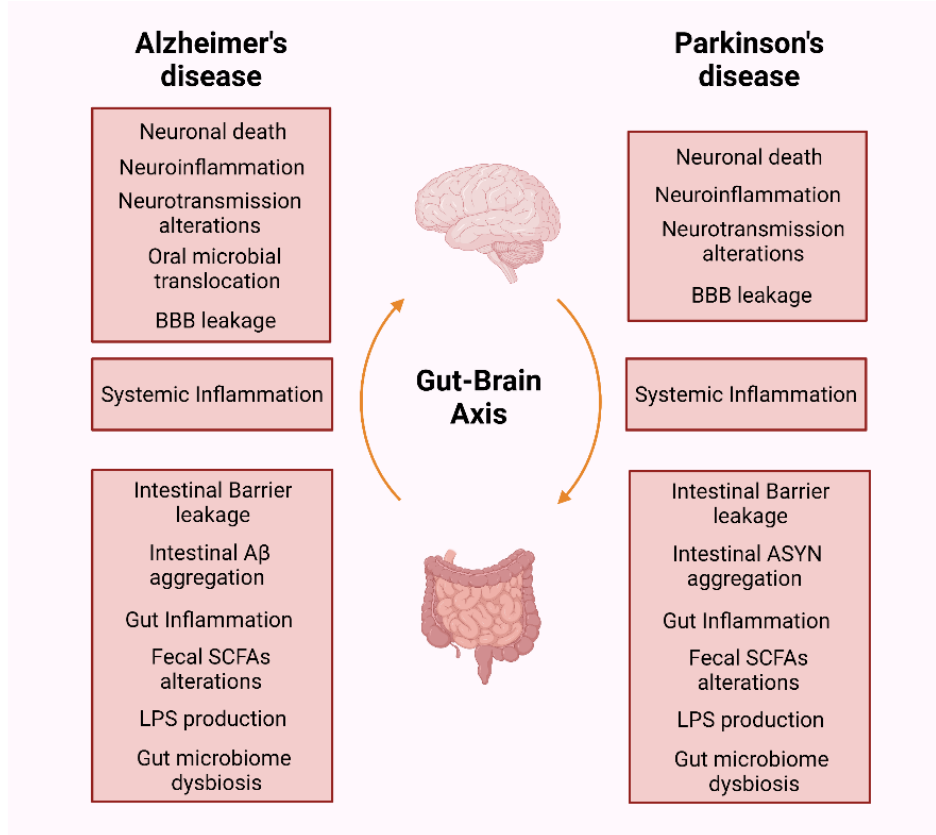
Figure 3. Evidence of gut–brain axis involvement in AD and PD. Schematic representation highlighting the pathophysiologic mechanisms that occur from the ENS to the CNS in AD and PD. Created by Biorender.